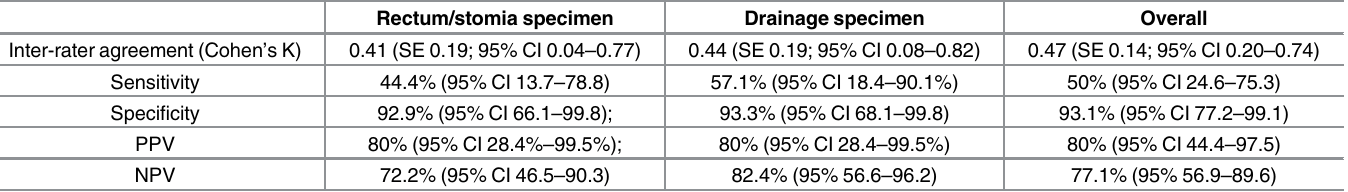
Table 3. Performance of Xpert Carba-R in comparison with microbiological culture for detection of carbapenem resistance by all genes (detect- able and non detectable by both methods) in our cohort of